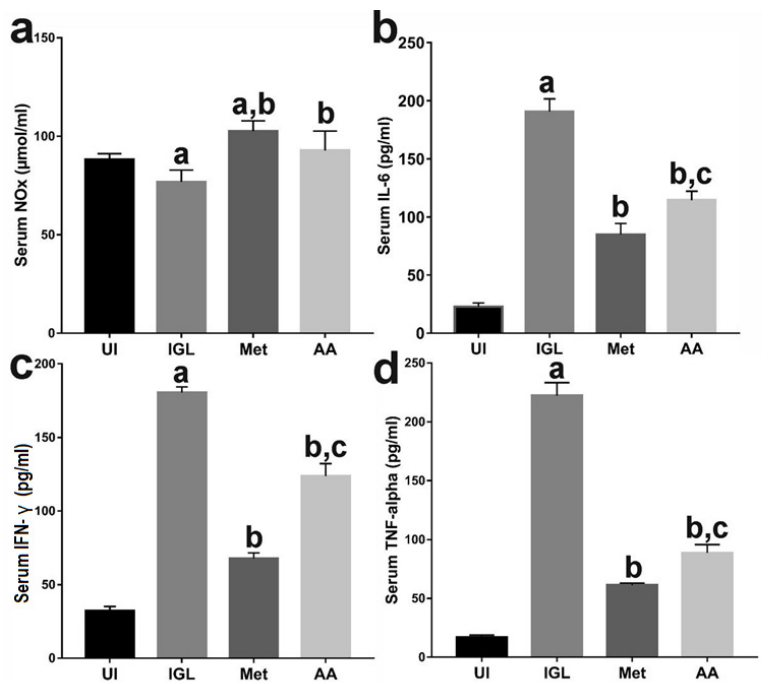
Figure 2. The effect of A. annua treatment on NO and proinflammatory cytokine levels in ham- sters infected with G. lamblia . We measured NO end products (NOx) in serum of different groups ( a ) (“a” indicates a significant difference versus UI group ( p < 0.001), while “b” indicates a significant difference versus IGL ( p < 0.001)). Serum levels of IL-6 ( b ), IFN- γ ( c ), and TNF- α ( d ) were also quan- tified (“a” indicates a significant difference versus UI group, “b” indicates a significant difference versus IGL group, and “c” indicates a significant difference versus Met group ( p < 0.05)). Values repre- sent means ± SD (n = 8), and data were analyzed using ANOVA with Bonferroni corrections as a post hoc test. UI = uninfected animal group, while IGL = infected and untreated animals. Met = infected animals treated with metronidazole and AA = infected animals treated with A. annua